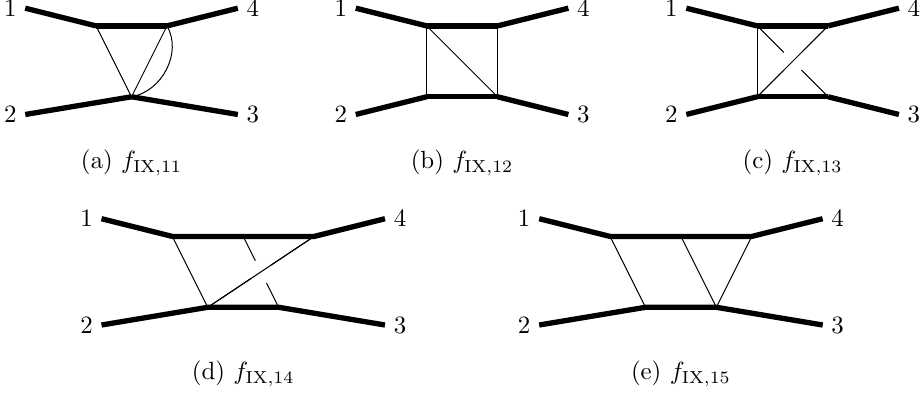
q master integrals relevant for the non-planar double-box topology. j j